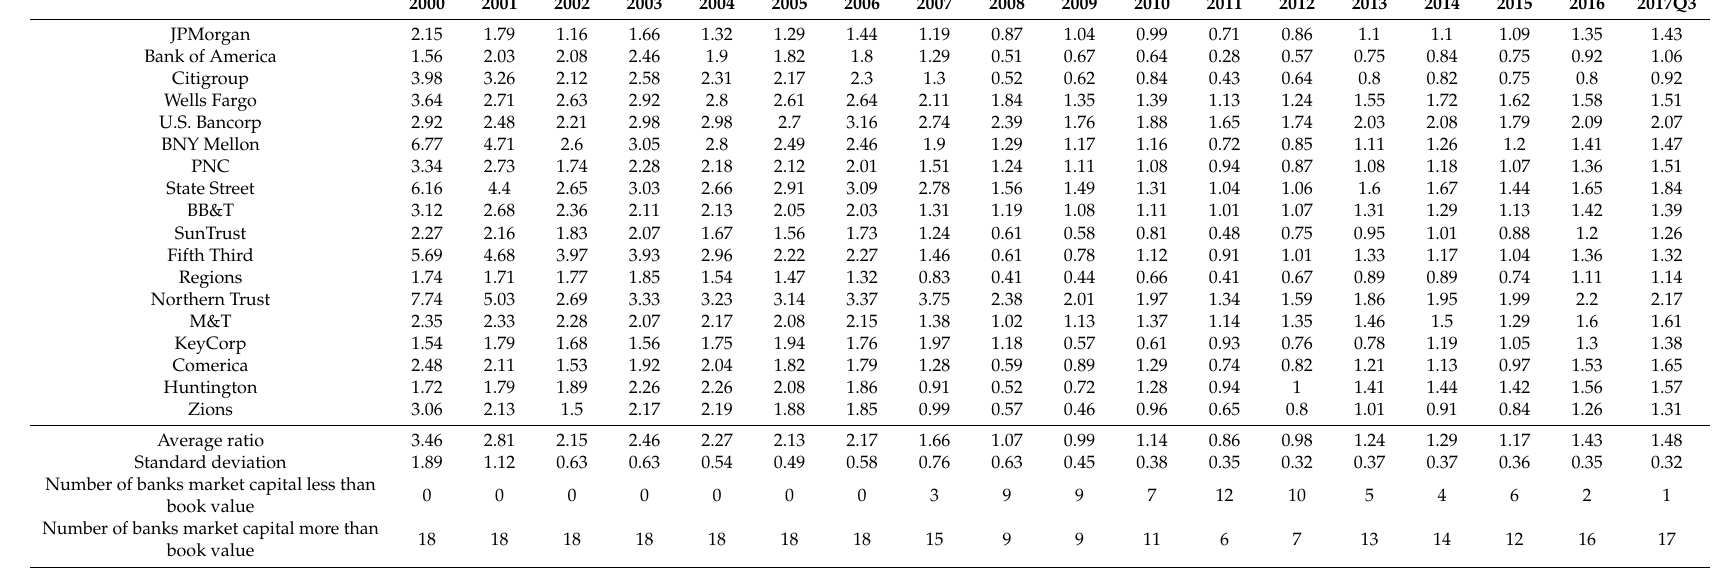
Table A6. Market Capitalization to Book Value